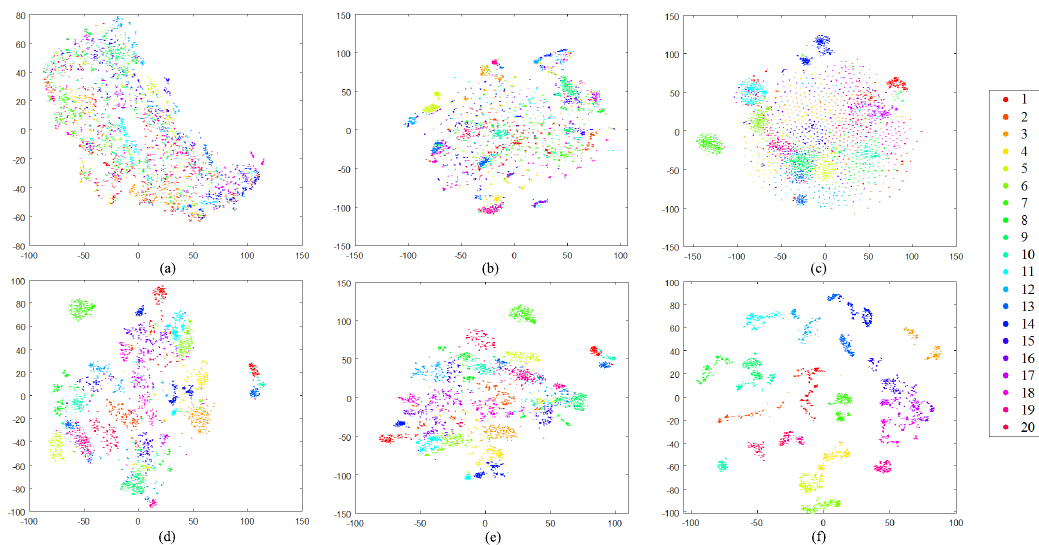
Figure 14. Two-dimensional scatterplots of different high-dimensional features obtained by t-SNE over ImgDB2 with 20 semantic classes. The relationships between number ID and semantics can be found in Figure 10. ( a ) HT; ( b ) CH; ( c ) S-BOW; ( d ) DN-7; ( e ) DN-8; ( f )